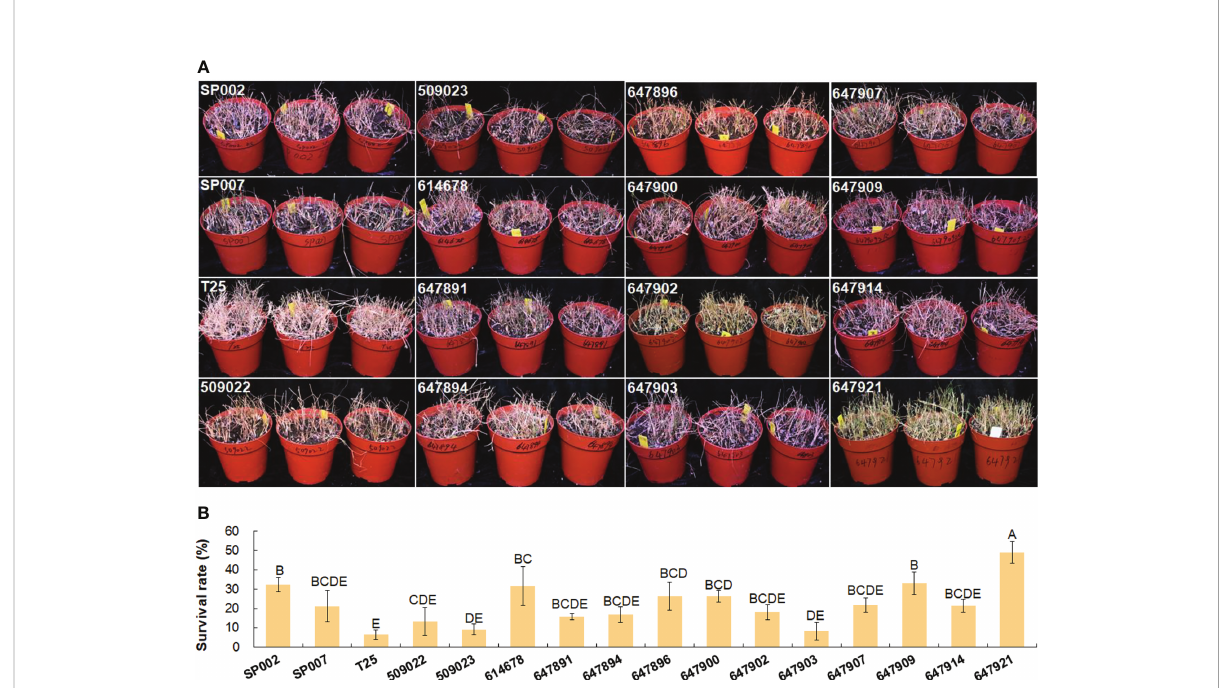
FIGURE 7 Analysis of salt tolerance in 16 seashore paspalum ecotypes. Photographs were taken when NaCl concentration was increased to 700 mM for 7 weeks (A) ; then survival rates were calculated after salt treatment by watering to wash salt for 7 d (B) . Means of three replicates and standard errors are presented; the same letter above the column indicates no signi fi cant difference at P